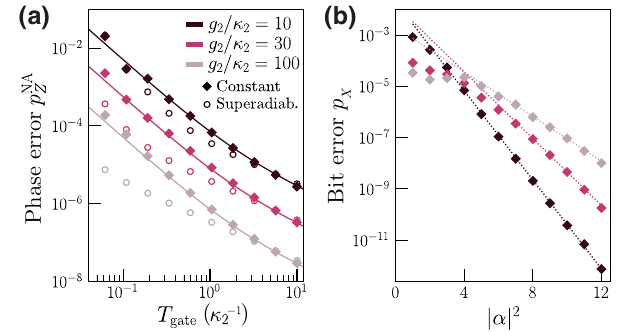
FIG. 8. (a) Gate-induced phase errors for a Z gate at | α | 2 = 8 with different confinement schemes: two-photon dissipation (green), combined Kerr and two-photon dissipation at K /κ 2 = 0.3 (gray), and combined TPE and two-photon dissipation at g 2 /κ 2 = 10 (magenta). (b) Total phase errors for the same Z gates, assuming single-photon loss at rate κ 1 = 10 − 3 κ 2 , thermal noise n th = 10 − 2 , and pure dephasing κ φ = 10 − 5 κ 2 . The com- bination of TPE and dissipative confinement allows us to win almost one order of magnitude on the phase error, and operates optimally almost one order of magnitude faster. For both plots, a constant Hamiltonian drive ε Z is used and gate times are in units of 1 /κ 2 . Markers indicate numerical data, dashed lines indicate analytical fits.